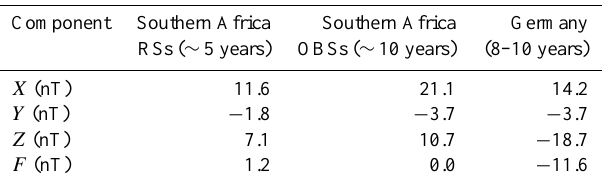
The offsets between lithospheric field estimates when only the core and when both core and magnetospheric contribution are removed depend on time. The tabulated values are averaged over all stations and, depending on data availability, in general 5 years for the southern African repeat stations (RSs) and 10 years for the southern African observatories (OBSs) and all German